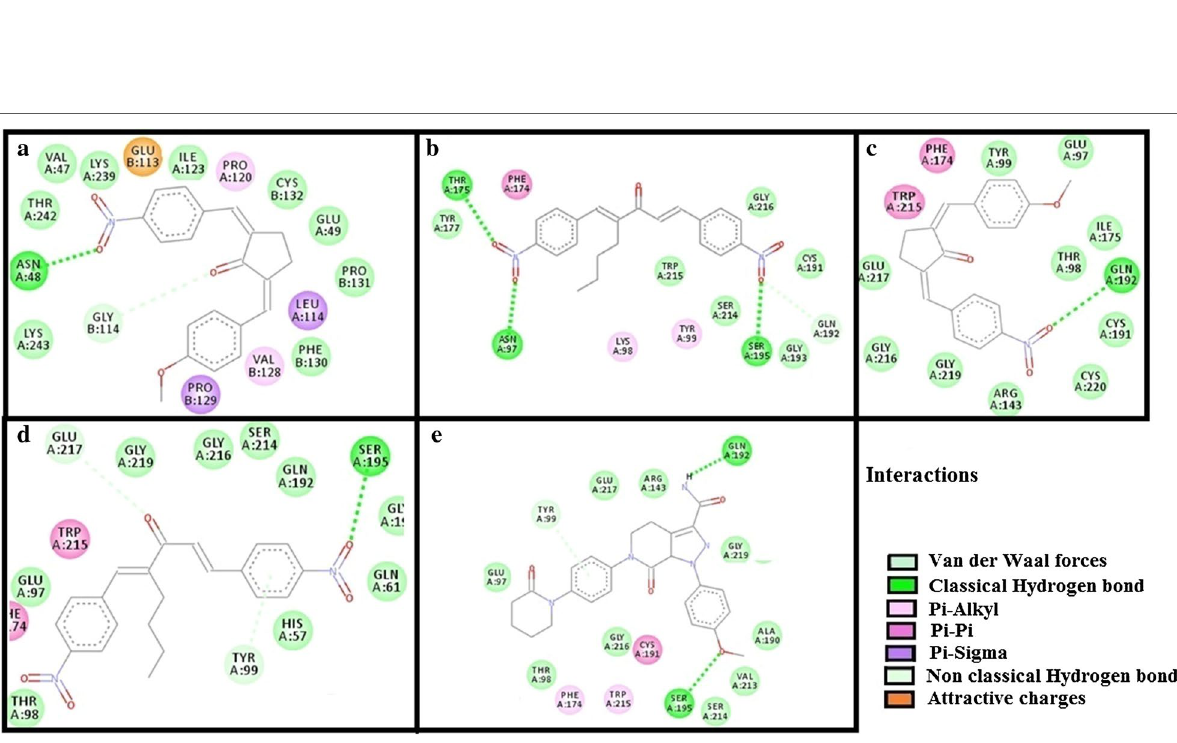
Fig. 11 a , b Represents interactions of ligands: (2 E ,5 E )‑2‑(4‑methoxybenzylidene)‑5‑(4‑nitrobenzylidene) cyclopentanone (AK‑1a) and (1 E ,4 E )‑4‑(4‑ nitrobenzylidene)‑1‑(4‑nitrophenyl) oct‑1‑en‑3‑one (AK‑2a) with target factor‑IX (F‑IX) respectively. c – e Represents interaction of AK‑1a, AK‑2a and apixaban with target: factor‑X (F‑X) respectively, drawn through Biovia Discovery Studio Visualizer client